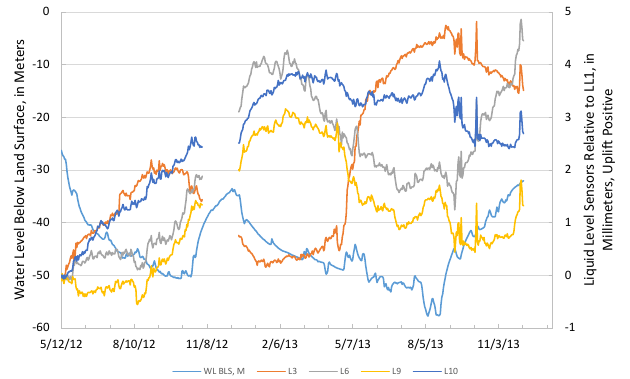
Figure 3. Vertical movement of liquid-level sensors with respect to LL1 compared with water-level fluctuation in observation well 0.8km to the south. Sensor locations are in Fig. 1.